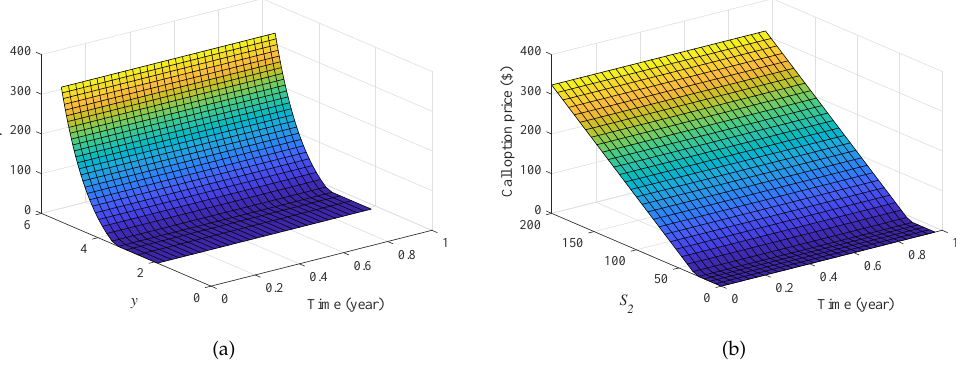
Figure 3. ( a ) Transformed explicit solution, v , and ( b ) call option price, c , for all time of order α = 0.9 with S 1 =